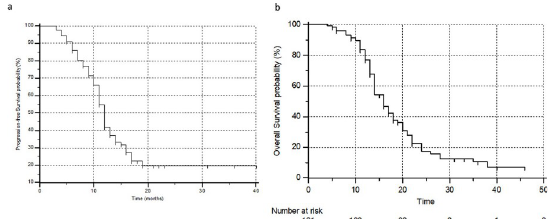
Fig 2. a. Progression-free survival according to PCWG3 criteria, b. overall survival.